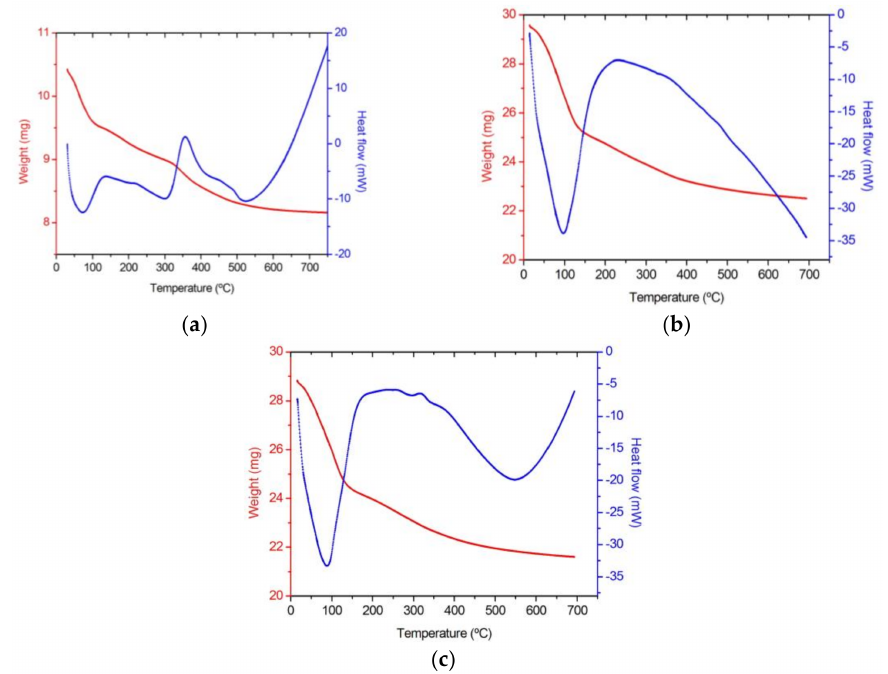
Figure 2. DTA and TGA diagrams of some of the samples studied. ( a ) Pure SiO 2 gel; ( b ) La(Ac) 3 doped gel; ( c ) La(NO 3 ) 3 doped